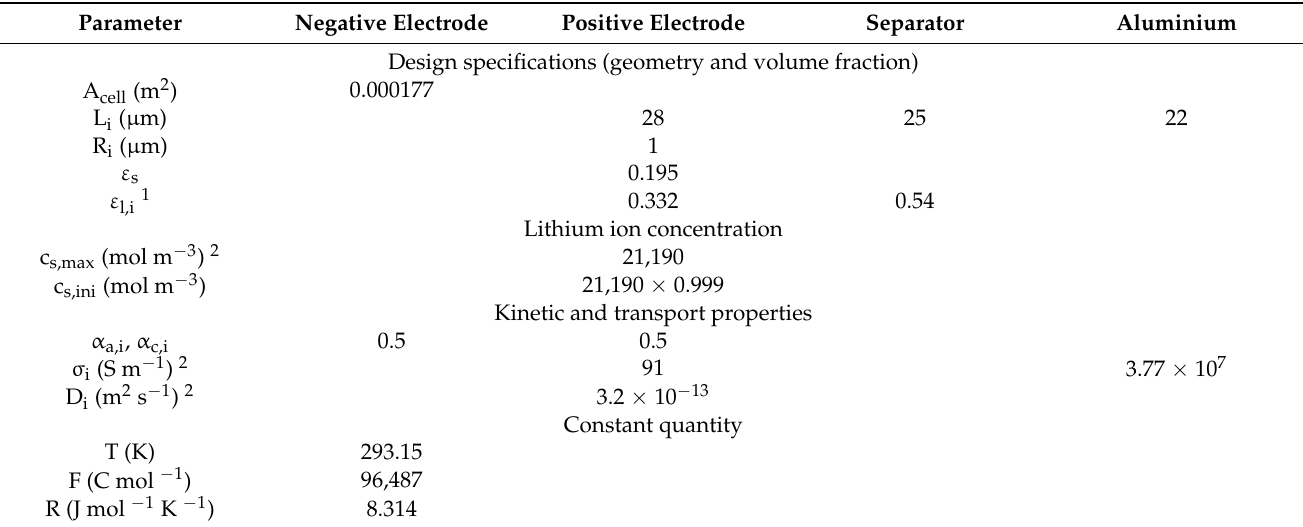
Table 2. Electrochemical parameters used for the